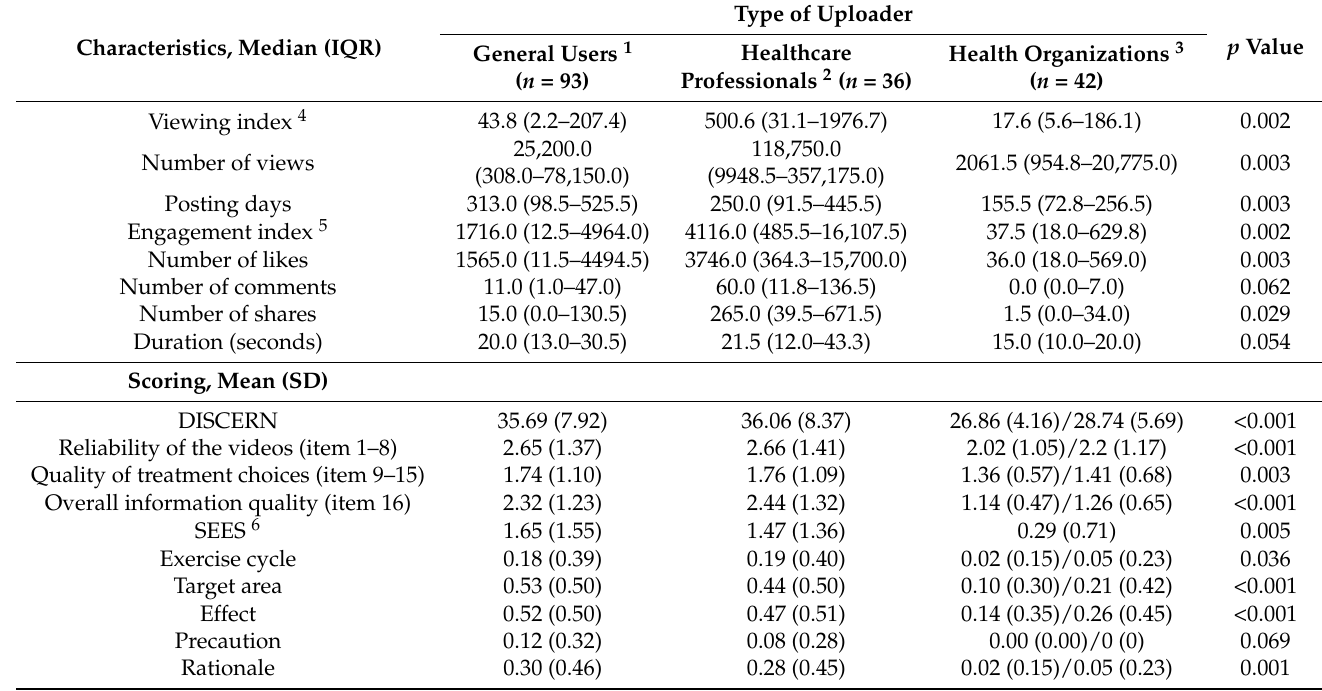
Table 2. Characteristics of the videos by type of